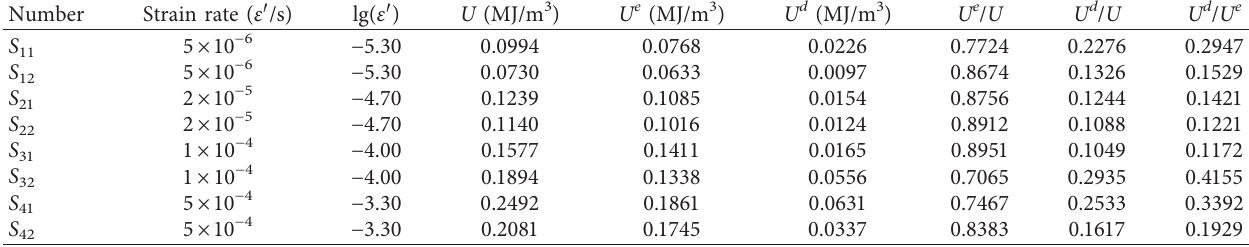
Table 2: Strain energy at peak strength under different loading rates.